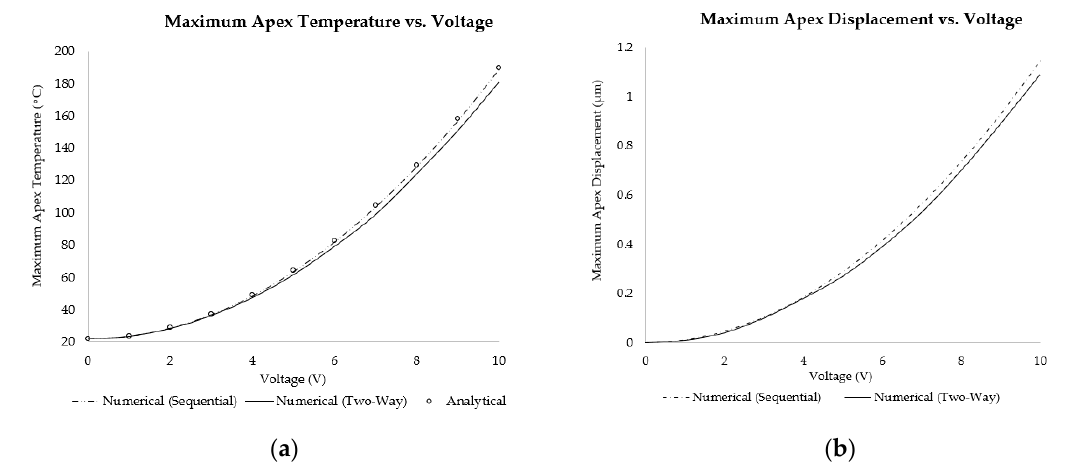
Figure 8. Plots of the ( a ) maximum temperature vs. voltage and ( b ) maximum displacement vs. voltage of the V-shaped ETA using analytical, sequentially coupled numerical and two-way system coupling numerical analyses.